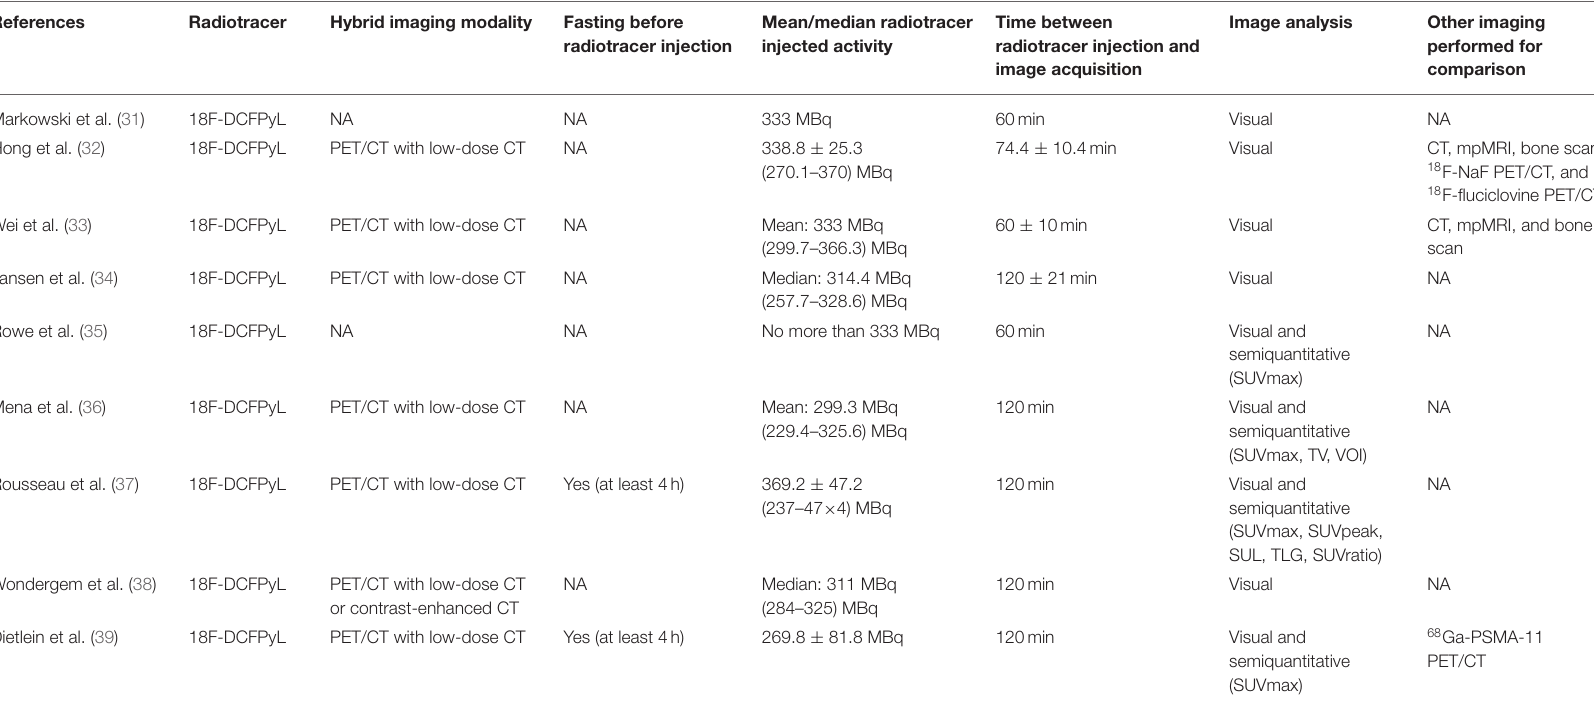
TABLE 2 | Technical aspects of the included